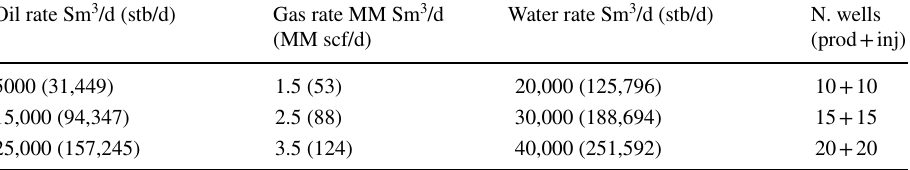
Table 1 Costs sensitivity